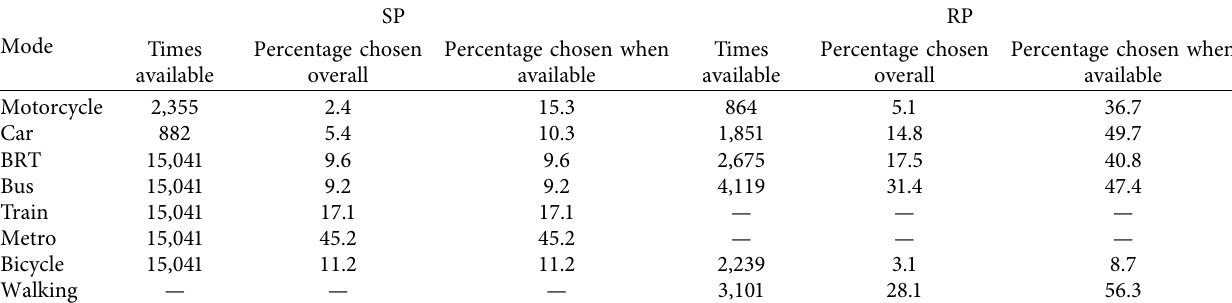
Table 2: Sample share of observed choices by